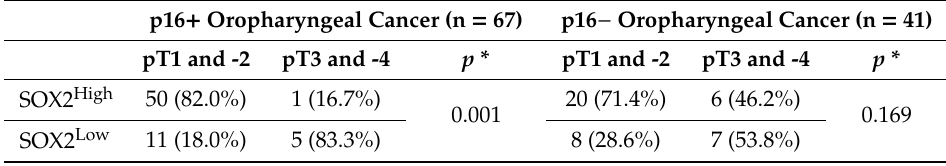
Figure 3. SOX2 IHC scores according to pathological T classification ( A ) and pathological N classification ( B ). *** p < 0.001. Table 2. Relationship between SOX2 immunohistochemistry score and pathologic T classification (pT) according to p16 + and p16 −